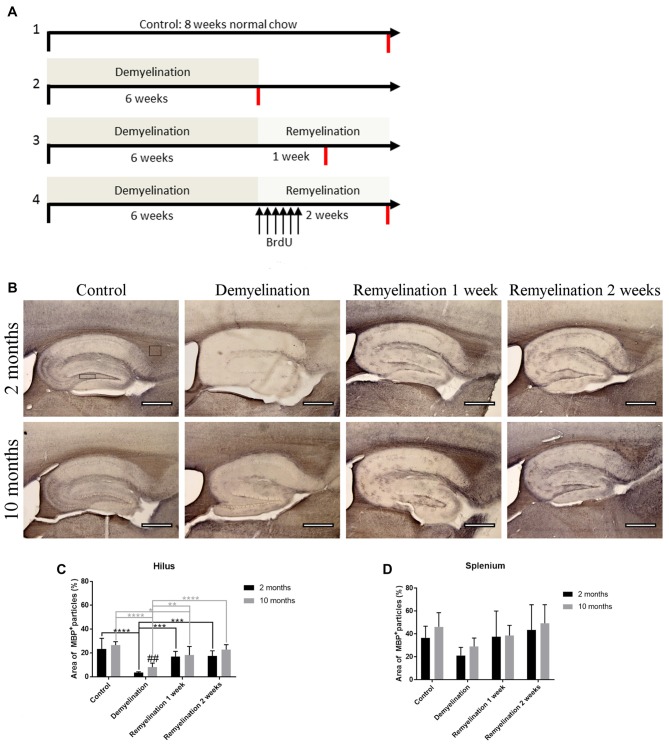
Experimental design and analysis of de- and remyelination. (A) Overview of the different treatment groups and the timeline of the experiment. All four treatment groups (controls, demyelination, 1 week remyelination and 2 weeks remyelination) were compared at two different ages: young (starting in 2-month-old animals) and middle-aged (starting in 10-month-old animals). To analyze proliferation and subsequent survival of microglia during remyelination, controls and the remyelination groups received six BrdU injections starting as soon as the demyelination-inducing cuprizone treatment was stopped. The red lines indicate the time of tissue collection. (B) Myelination was analyzed using staining for myelin basic protein (MBP). The analyzed regions of interest are indicated by rectangles. (C) In the hilus of the dorsal hippocampal dentate gyrus (DG), both age groups were significantly demyelinated, followed by remyelination beginning 1 week after the end of the cuprizone treatment. After six weeks of cuprizone treatment, demyelination was slightly, but significantly, more severe in the young group. (D) In the splenium of the corpus callosum (CC), the observed myelin changes during de- and remyelination were less pronounced. Values are shown as means + standard deviation (SD n = 6 per group). Statistical significance was evaluated using a two-way ANOVA followed by a Tukey’s post hoc test. The p-values are indicated in the graphs: treatment effects within the same age group: *p < 0.05, **p < 0.01, ***p < 0.001 and ****p < 0.0001, age-related differences: ##p < 0.01. Bars: (B) 500 μm.